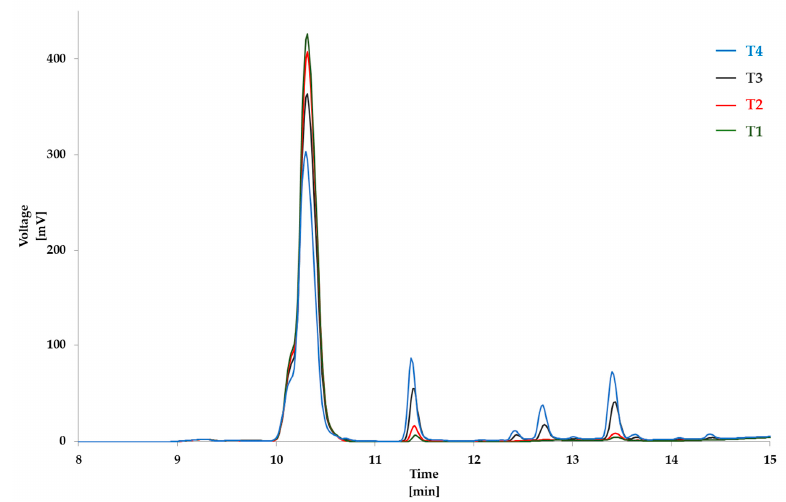
Figure 6. Overlaid chromatograms of N α -benzoylglycyl- L -lysine and derivatives in blank samples after different times of incubation at 180 °C (T1: 5 min, T2: 10 min, T3: 30 min, and T4: 60 min).